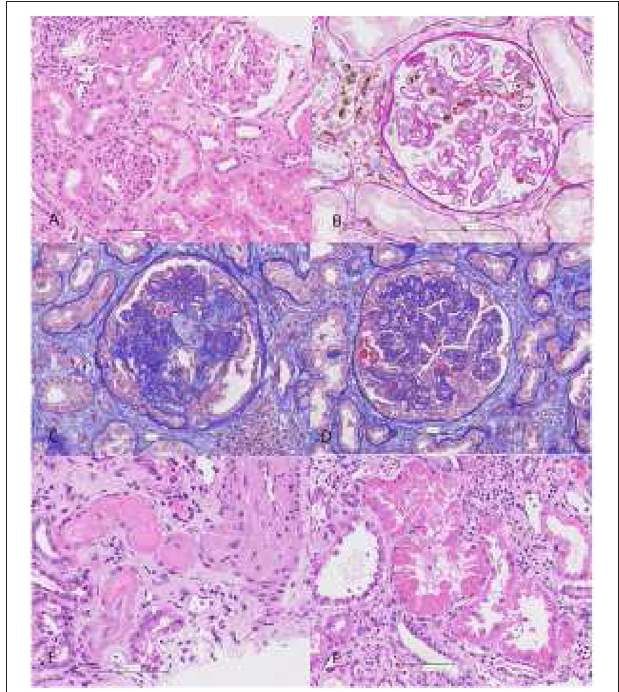
FIGURE 1 | Before application of MSCs (March 2019): chronic active C4d negative antibody-mediated rejection with preserved tubules (A) , focal glomerulitis and peritubular capillaritis (B) . According to Banff 2017 criteria, transplant kidney biopsy was consistent with chronic active C4d negative antibody mediated rejection: 12% glomerulitis with double contour formation (g1, cg3) in glomeruli, diffuse severe peritubular capillaritis (ptc3), chronic active vascular rejection (v1, cv3) in interlobular arteries without signs of thrombotic microangiopathy, diffuse more than 50% interstitial fibrosis and tubular atrophy with mild mononuclear cell inflammation consisting of lymphocytes, macrophages, and rare plasma cells (i-IFTA 3, ci3, ct3). There was no associated tubulitis. Peritubular capillary basement membrane multilamellation (ptcbm3) was seen by electron microscopy. There were no deposits in tubular basement membrane. Immunofluorescence revealed IgA deposits indicating IgA nephropathy recurrence. 60% of glomeruli were globally sclerotic. 1 of 25 glomeruli showed pseudocrescent formation without PAS positive droplets in podocytes. After application of MSCs (July 2019): glomerular TMA with mesangiolysis (C) , diffuse pseudocrescent formation in glomeruli with marked podocytes injury (D) , vascular TMA (E) and huge tubular injury with resorptive droplets consisted with mottled lysosomes on EM (F) . Glomeruli showed advanced double contour formation and segmental sclerosis without apparent glomerulitis, but mesangiolysis was seen in some glomeruli. 20% of glomeruli showed pseudocrescent formation with PAS positive droplets “in podocytes indicating huge podocytes injury”. Peritubular capillaritis was mild and focal. Tubulitis was absent. Tubules show signs of severe tubular injury (attenuation of tubular epithelium with coarse vacuolization, loss of brush border, loss of nuclei) and were filled with large PAS-positive droplets in line mottled lysosomes on electron microscopy. Electron optic dense deposits in tubular basement membrane were detected by EM. Amount of interstitial fibrosis, tubular atrophy, and interstitial inflammation was similar as in previous biopsy. In fibrotic areas, there was mild mononuclear cell inflammation consisting of lymphocytes 75%, macrophages 15%, and plasma cells 10%. No CD105 + , CD73 + nor CD90 + cells were found. In small arteries and arterioles, thrombotic microangiopathy with obliteration of vascular lumens, fragmentation of erythrocytes, and fibrinoid necrosis was present. Peritubular capillary basement membrane multilamellation (ptcbm3) was similar as in previous